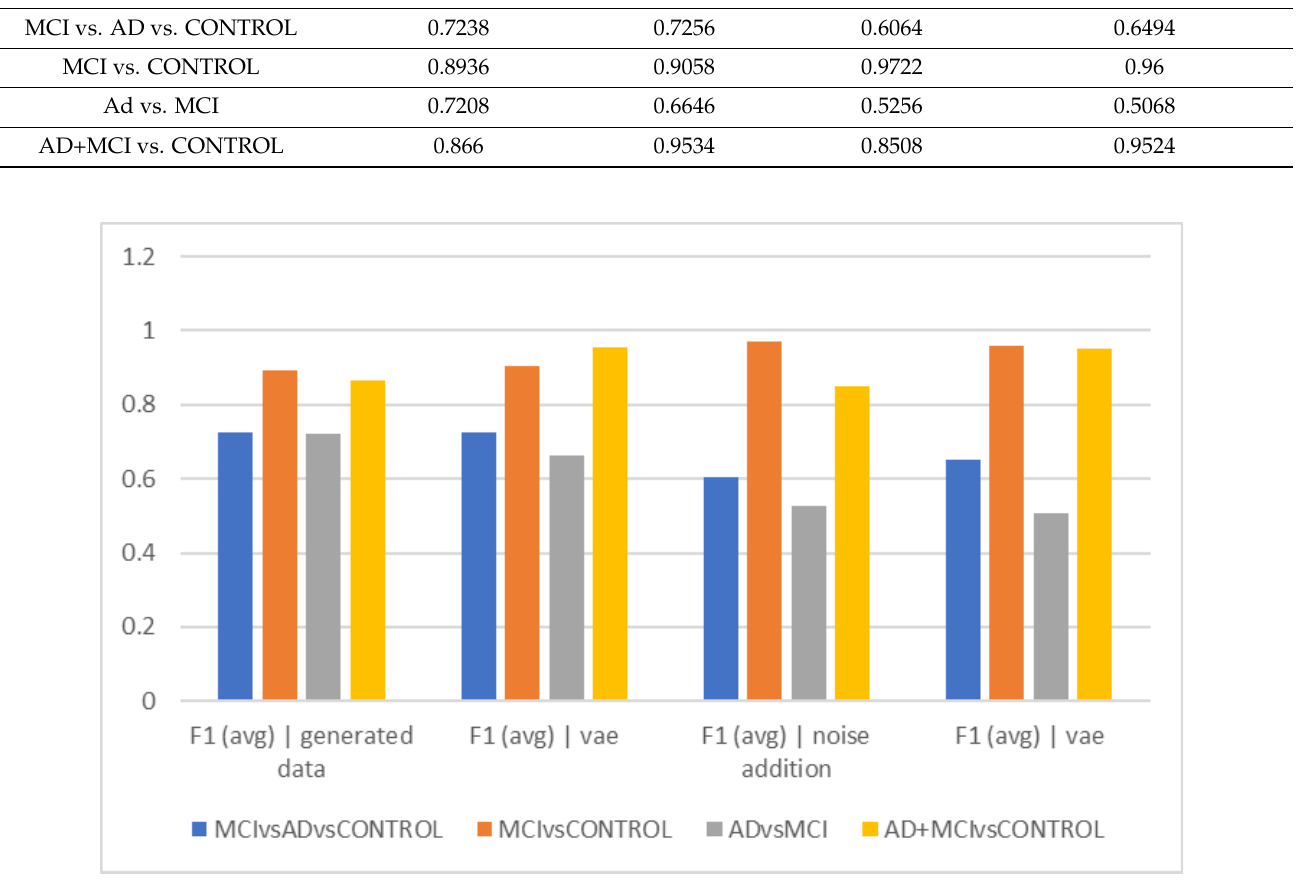
Table 7. Average accuracy and F1Score criteria for 50 trials for different time intervals. Results for 15 s (F1).